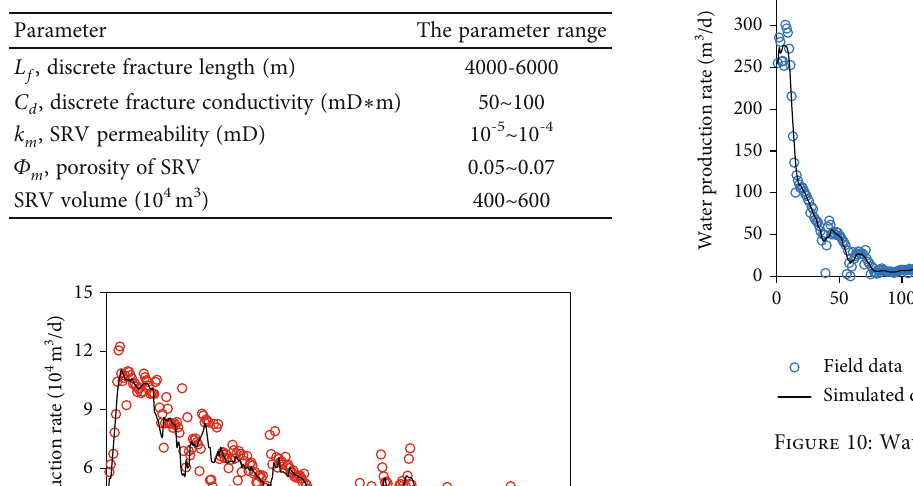
Table 2: Scope of key parameters of seam mesh.